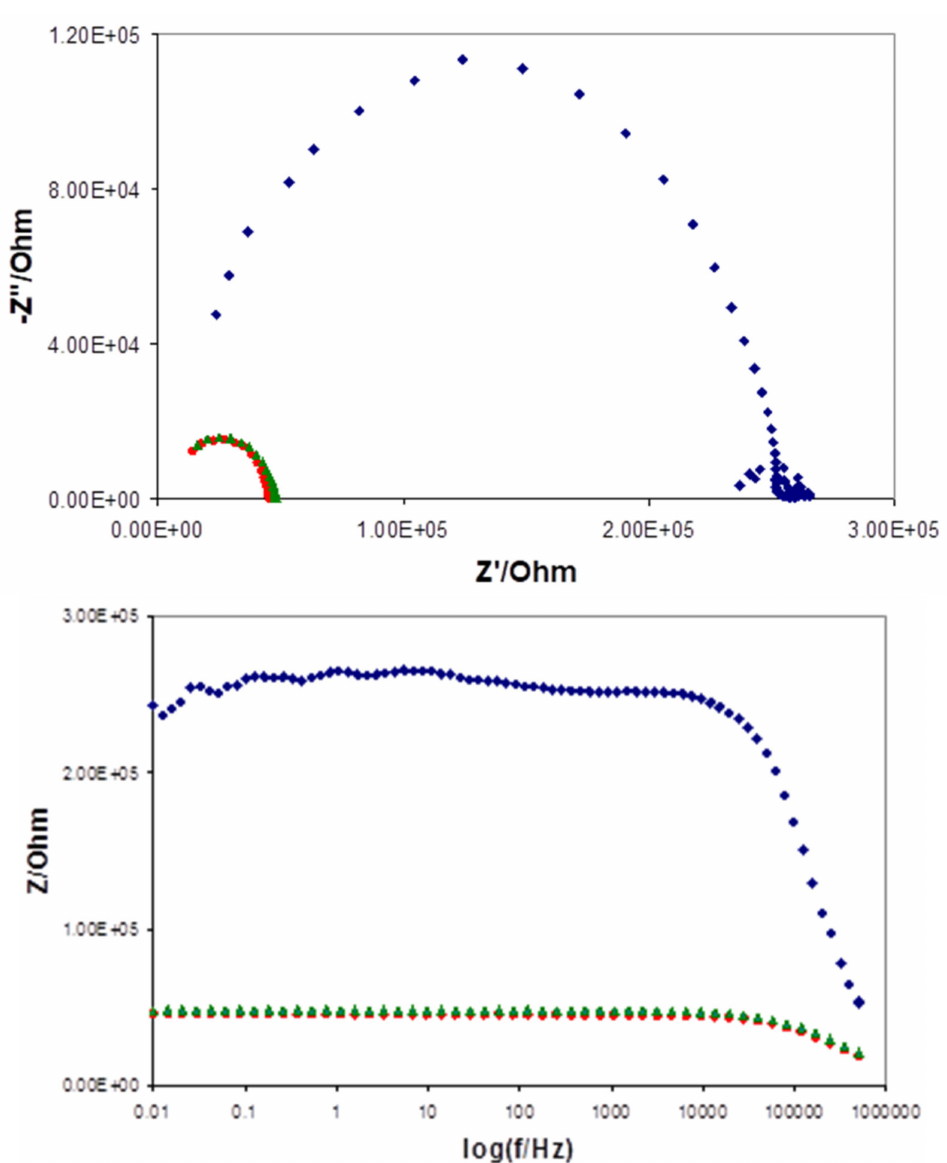
Figure 6. EIS spectra of the 1a type (blue rectangle), 1d type (red circle), and 1e type (green triangle) electrodes recorded in 0.1 M KCl solution under open circuit potential. Frequency range 500 kHz—0.01 Hz, amplitude 20